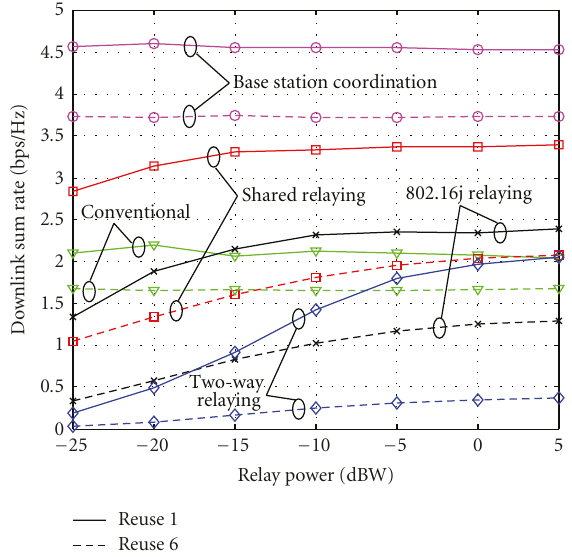
Figure 8: Downlink sum rates for each of the strategies presented in this paper as a function of the relay transmit power. The solid lines represent reuse factor 1, while the dotted lines represent reuse factor 6.